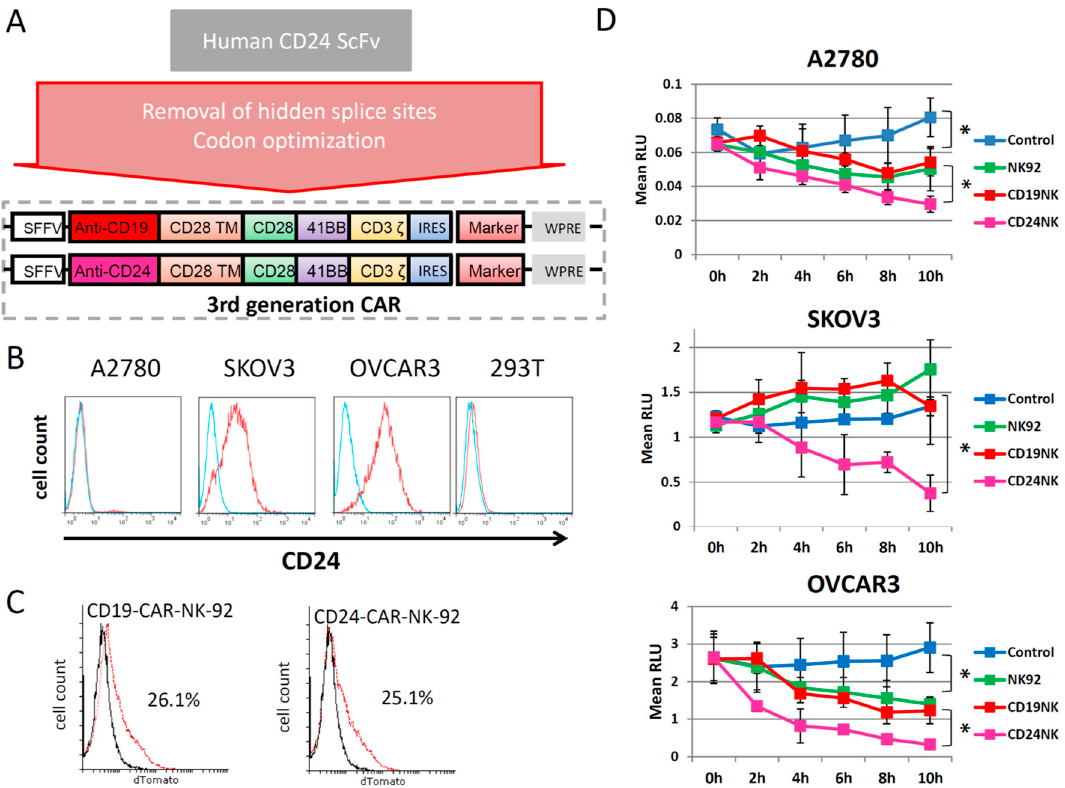
Figure 1. A new codon-optimized anti-CD24-CAR kills CD24 expressing ovarian cancer cells. ( A ) Schematic illustration of the structure of the tested CAR. ( B ) FACS analysis of the antigen expression of CD24 in different ovarian cancer cell lines. ( C ) FACS analysis of NK-92 cells engineered with their respective CAR (dTomato). ( D ) Fluoroskan results showing the killing effect of the engineered NK cells in ovarian cancer cell lines. In short, GFP-positive ovarian cancer cells were seeded in 96-well plates at previously determined densities (A2780, 2 × 10 4 cells/well; SKOV3 and OVCAR3 1.5 × 10 4 cells/well). NK-92 and CAR-NK-92 cells were added at the effector/target (E/T) ratio 5:1 one day later. Cells were lysed with SDS, and fluorescence intensity was measured at excitation 485 nm/emission 520 nm using Fluoroskan Ascent™ FL. RLU abbreviates relative light units. Values represent the mean from two separate experiments each containing three samples. * indicate p -values < 0.05.